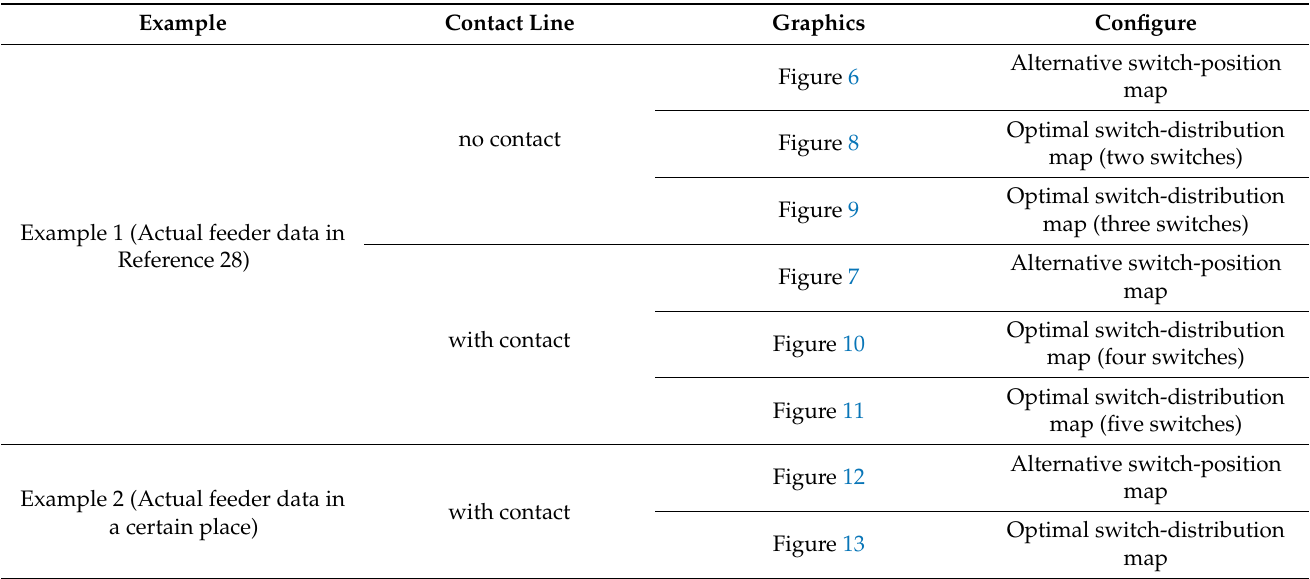
Table 3. Condition and operation